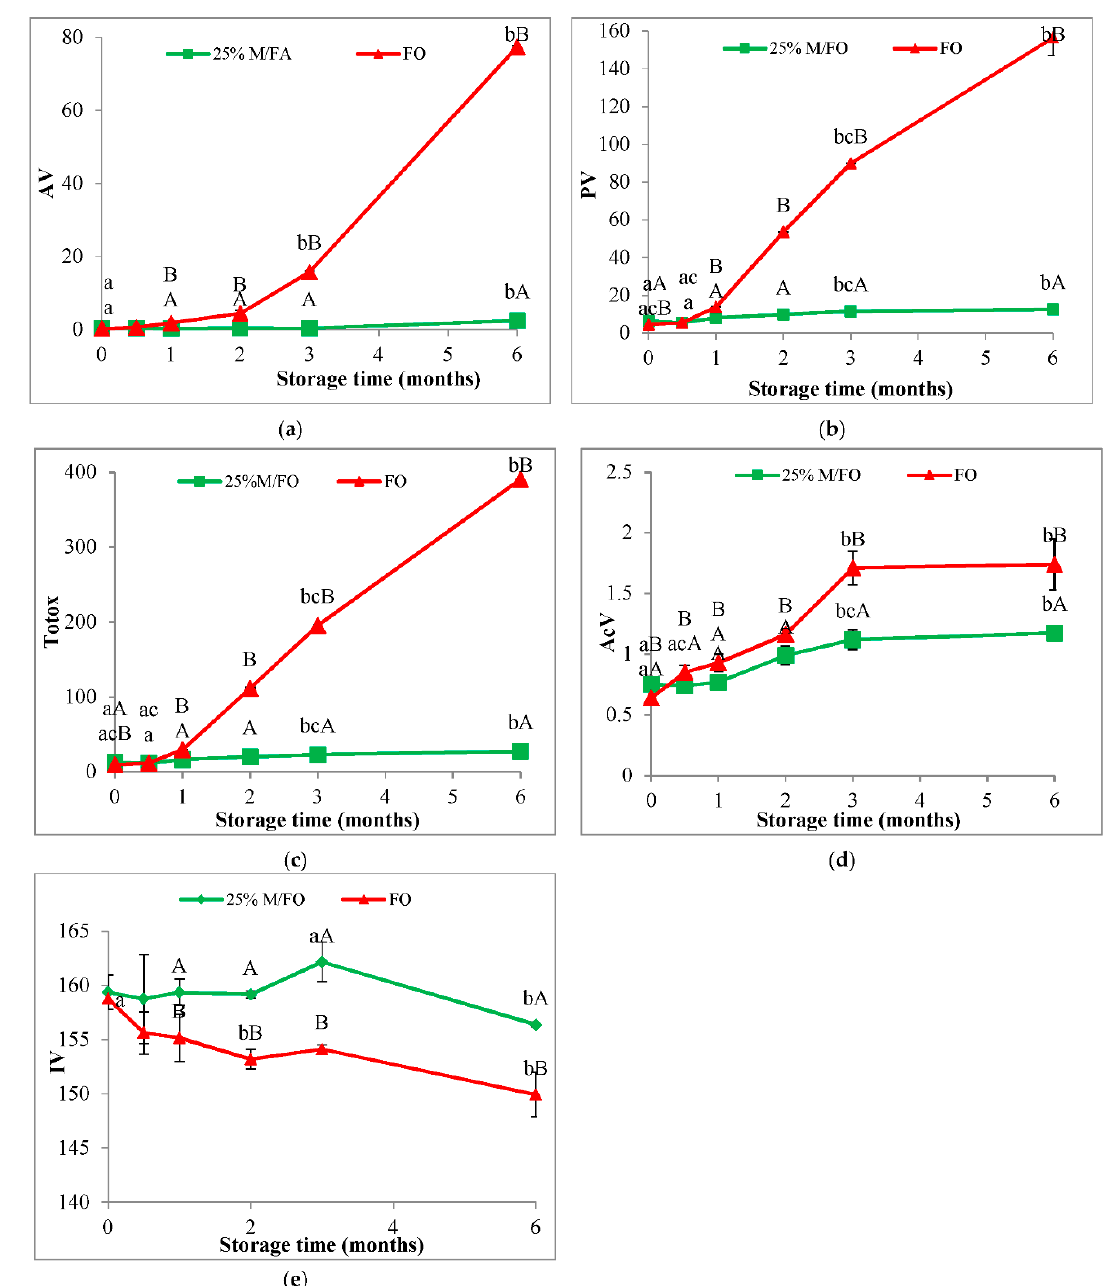
Figure 5. Anisidine value ( a ), peroxide value ( b ), Totox ( c ), acid value ( d ), iodine value ( e ) fish oil with macerate (25% M/FO, green) compared to control fish oil (FO, red) stored at refrigeration temperature (4 °C). (Values marked with the same lowercase letters a, b differ statistically significantly within the stored samples (25 M/FO or FO), while values marked with different uppercase letters—A, B differ significantly within the same storage time. Analogically values marked with the same letters do not differ statistically significantly, p < 0.05).